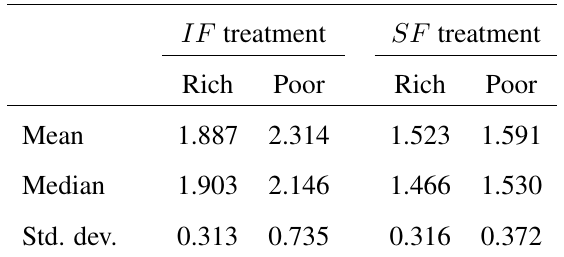
Table 2 . Summary statistics on observed cycle lengths in the two treatments ( N 18 for both rich and poor